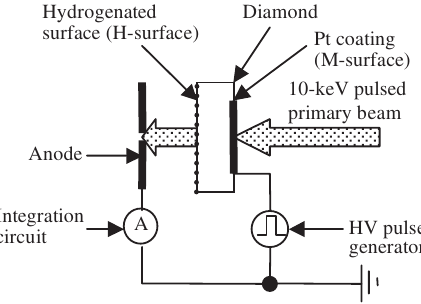
FIG. 1. Diagram of the previous DA emission experiment (see text for